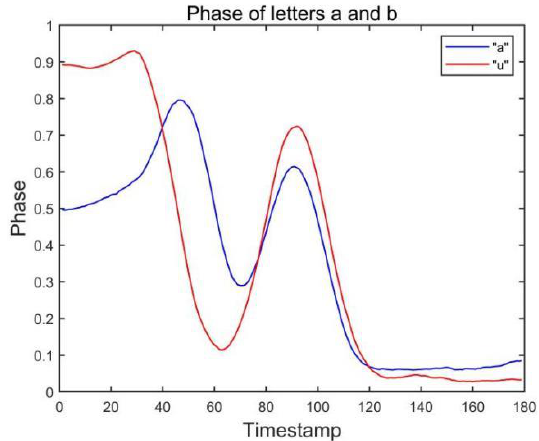
Figure 3. Phase of letters a and u collected by antenna #2.